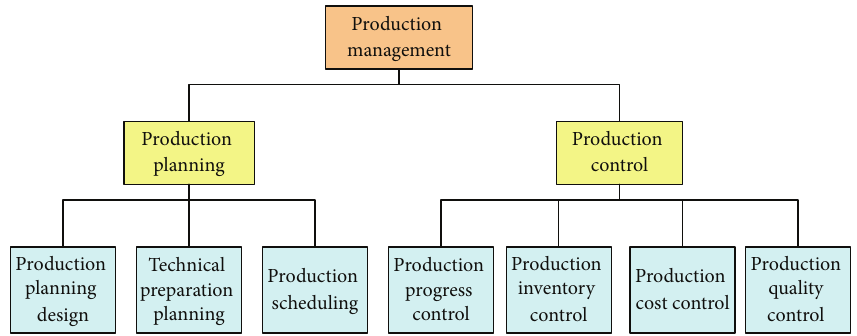
Figure 1: Function structure of production